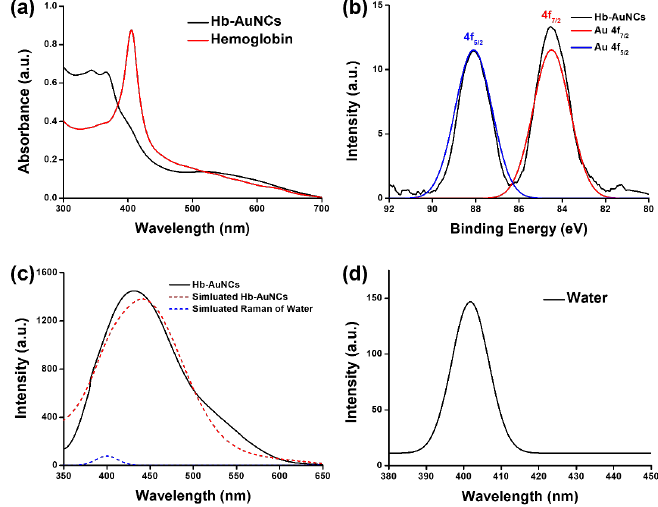
Figure 2. ( a ) Ultraviolet–visible (UV–Vis) absorption spectra of hemoglobin and hemoglobin-conjugated gold nanocomposites (Hb-AuNCs); ( b ) X-ray photoelectron (XPS) spectra of Hb-AuNCs (black line), the simulated peak of Au 4f 5/2 (blue line) and the simulated peak of Au 4f 7/2 (red line); ( c ) fluorescence spectrum of Hb-AuNCs composed of the simulated fluorescence spectrum of Hb-AuNCs and the simulated Raman signal of water. The excitation wavelength was 314 nm; ( d ) Raman signal of water was measured with the excitation wavelength of 314 nm by fluorescence spectrometer. In the TEM image of Figure 3a, Hb-AuNCs revealed an approximately globular shape. As shown in the histogram of Figure 3b, the size distribution of Hb-AuNCs was systematically counted